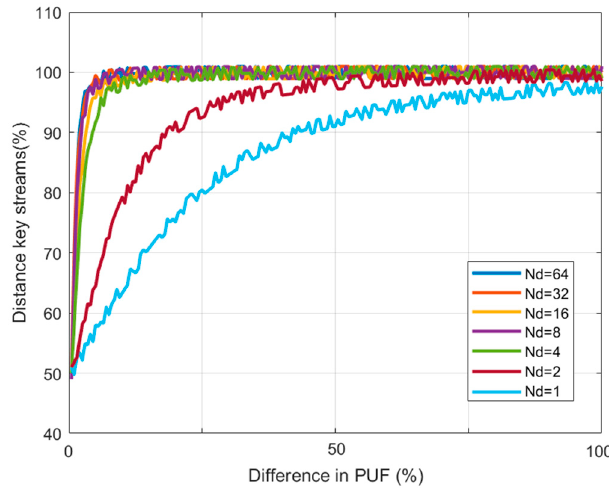
Figure 11. Results from the third experiment.